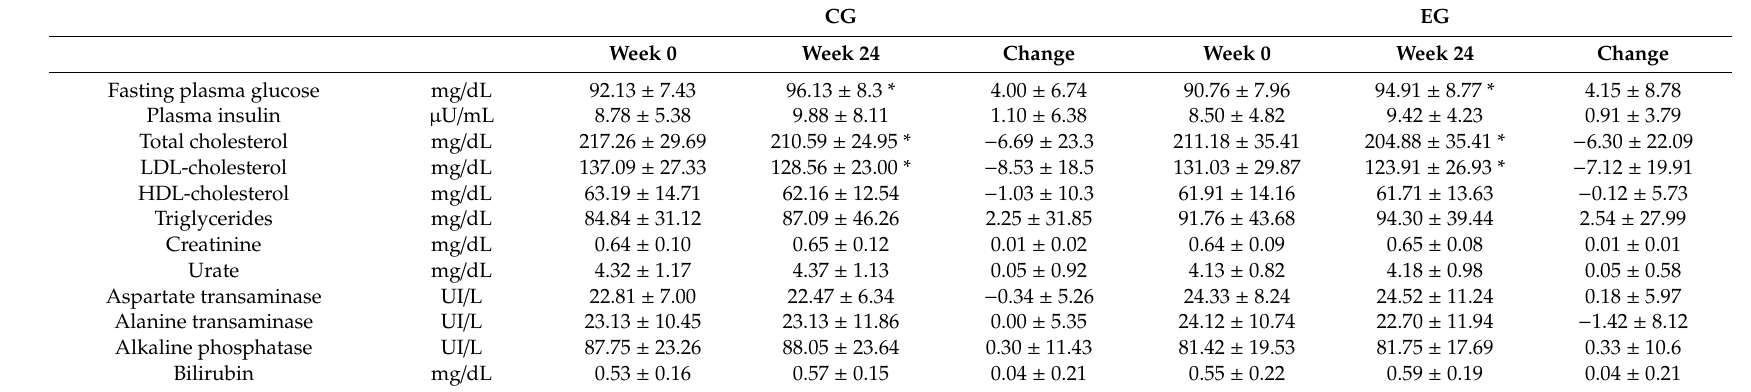
Table 2. Biochemical safety parameters of the study’s participants before and after the intervention.